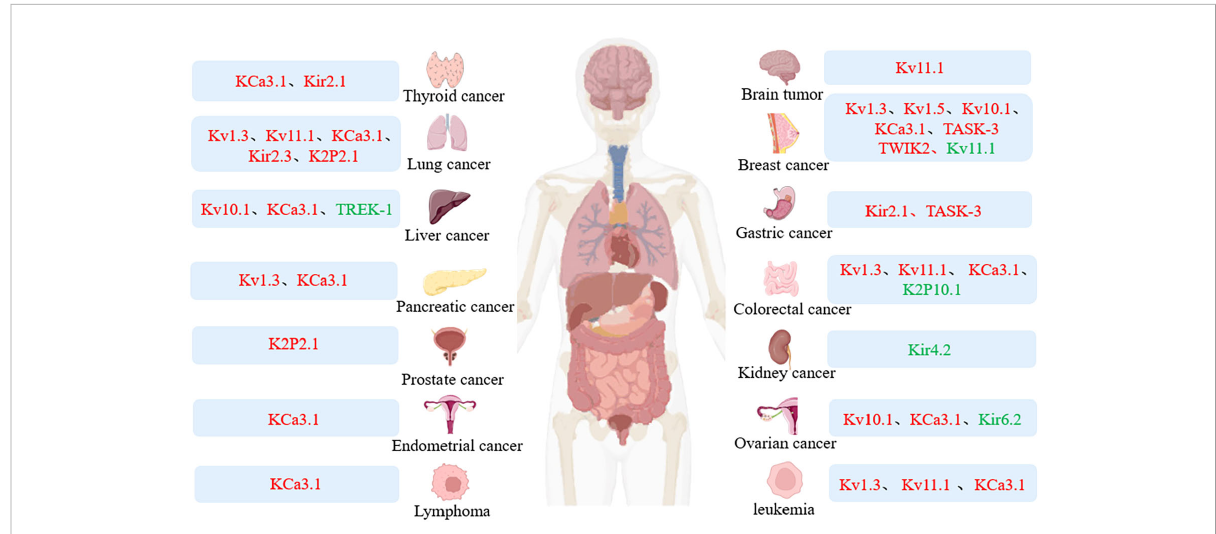
FIGURE 1 Expression of potassium channel in tumor. Colors represent different expression levels: red, high expression; green, low